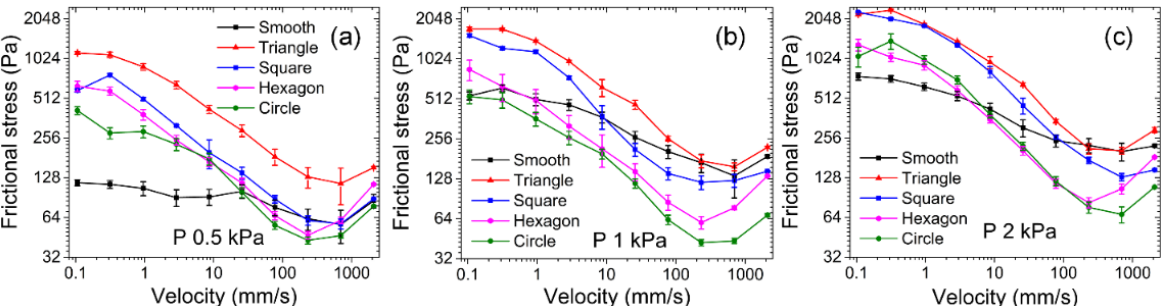
Figure 9. Variation of frictional stress on hydrogel surfaces containing micro-pits of different shapes with the hydrogels serving as substrates. ( a ) P = 0.5 kPa, ( b ) 1 kPa, and ( c ) P = 2 kPa. The effect of micro-pits of different shapes on friction was consistent with that when the titanium alloy was the substrate. The ranking “σ (triangular) > σ (quadrilateral) > σ (hexagonal) > σ (circular)” was still correct.